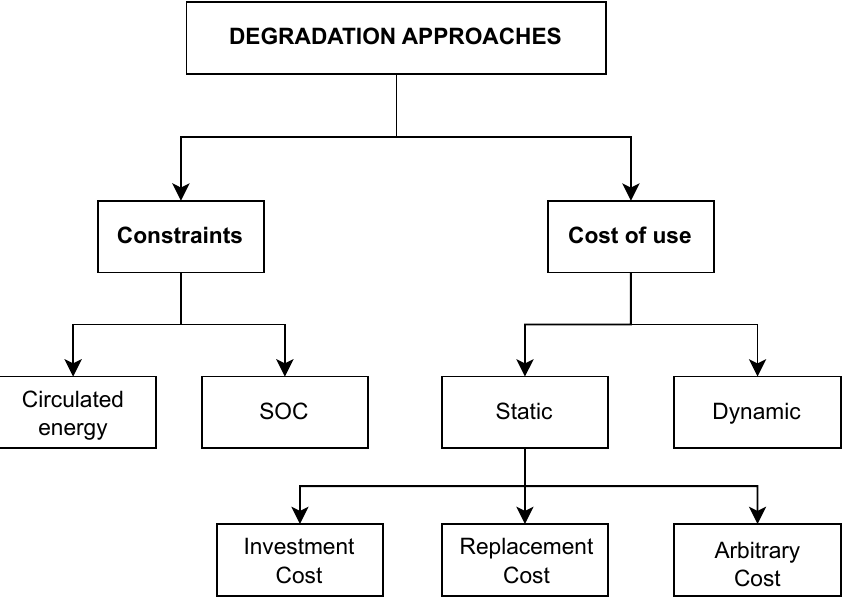
Figure 1. Classification of degradation